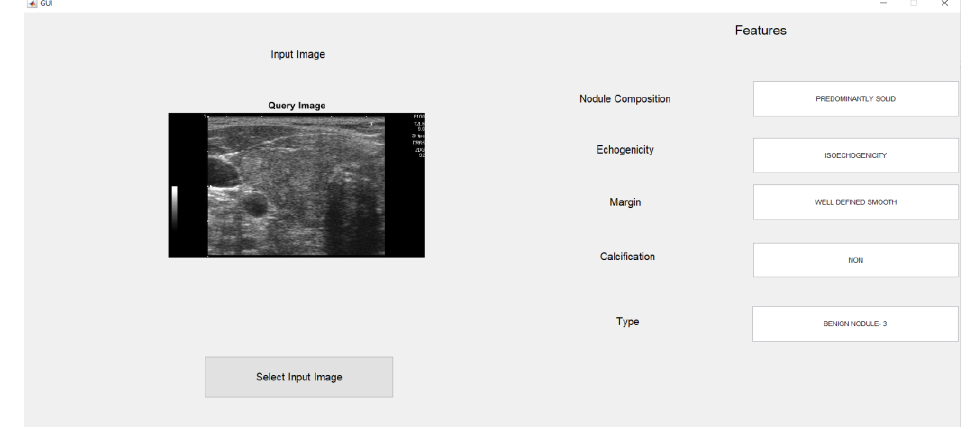
Figure 13. GUI for benign nodules.